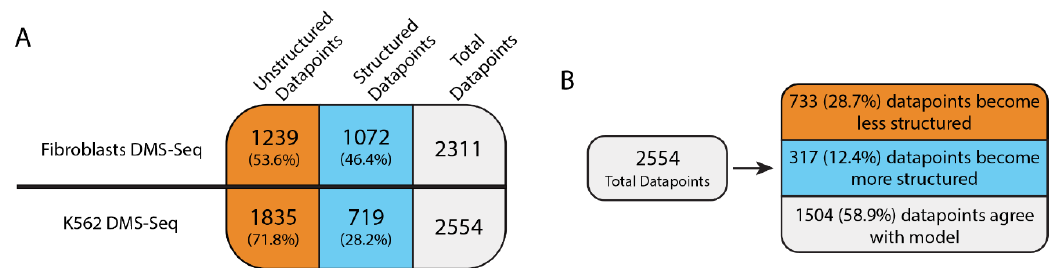
Figure 1. Summary of DMS-Seq data analysis. ( A ) 2311 available DMS-Seq datapoints (i.e., number of DMS-Seq reads corresponding to a single adenosine or cytidine) in human foreskin fibroblasts and 2554 DMS-Seq datapoints in K562 cells were classified as unstructured or structured based on whether they exceeded the 20-read or 250-read threshold, respectively (see Section 3 and [15]). ( B ) K562 DMS-Seq datapoints were compared to the working MALAT1 consensus model and further classified as losing structure, gaining structure, or agreeing with the model [15].